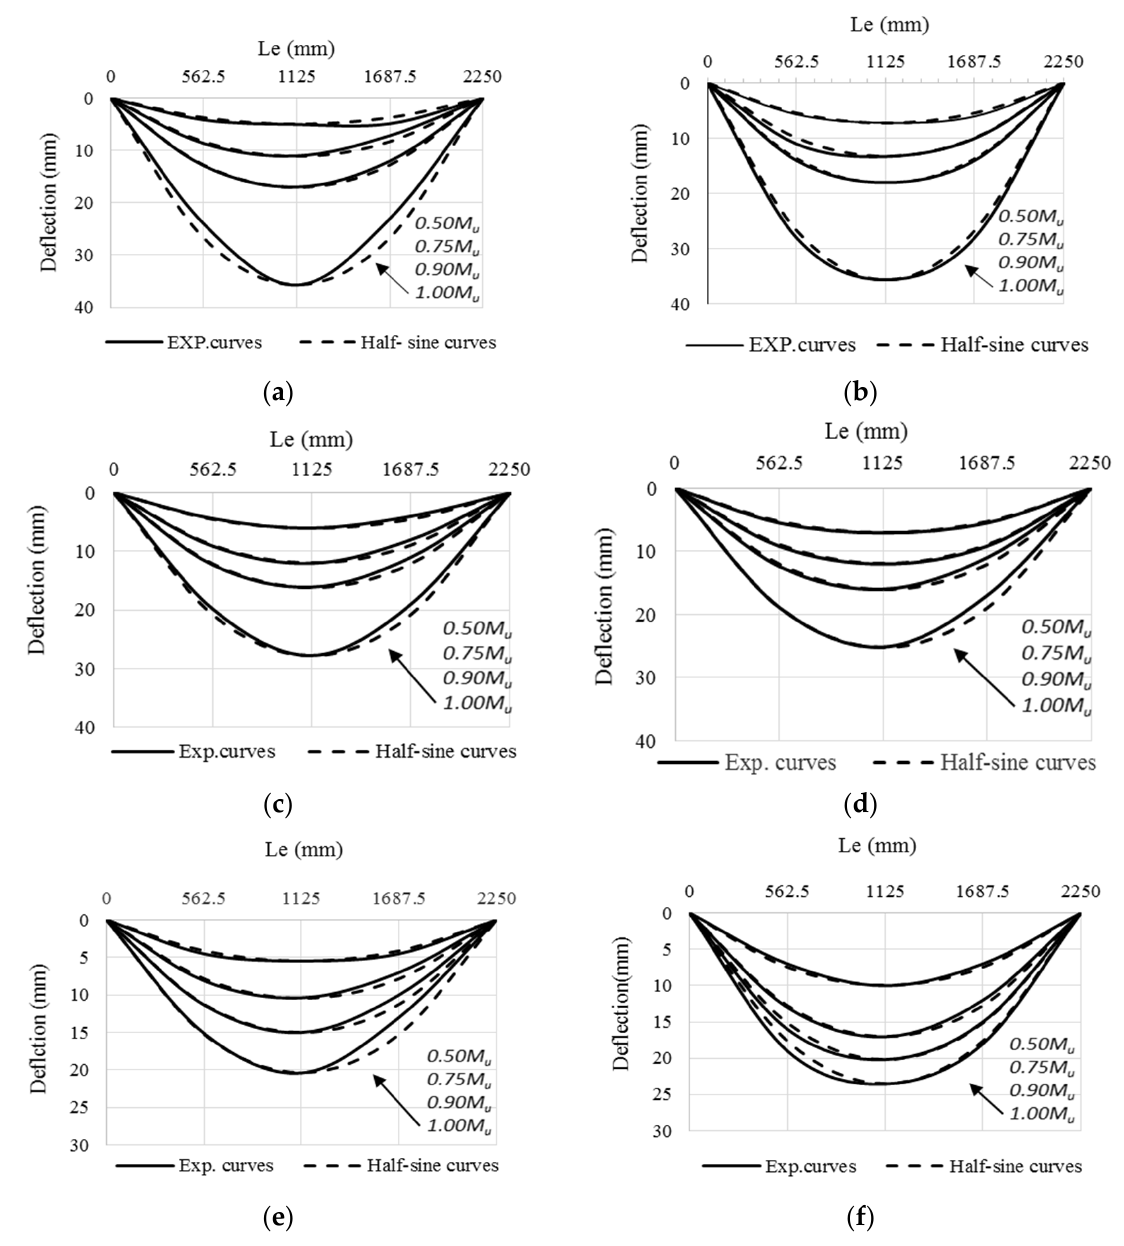
Figure 11. Deflection curves of CBPDS specimens. ( a ) CBPDS-DF0; ( b ) CBPDS-DS0; ( c ) CBPDS-DF50; ( d ) CBPDS-DS50; ( e ) CBPDS-DF100; ( f ) CBPDS-DS100.